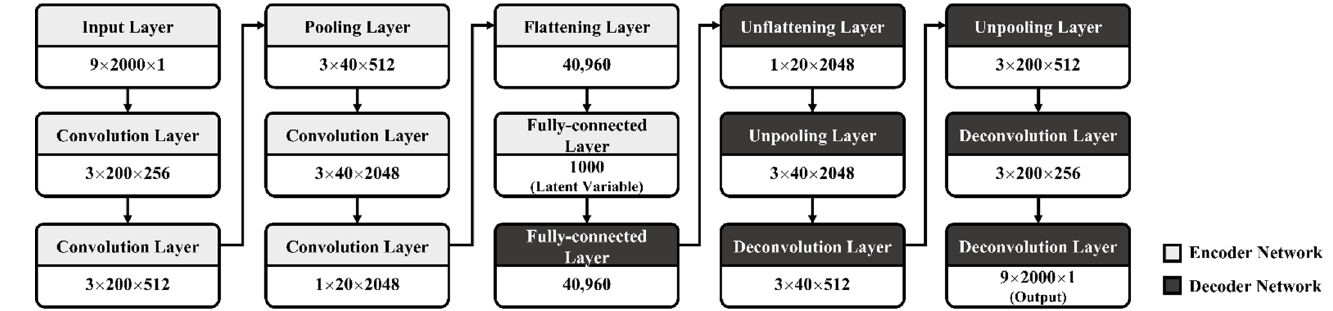
Figure 6. CAE architecture for rigid-frame-bridge-damage detection.